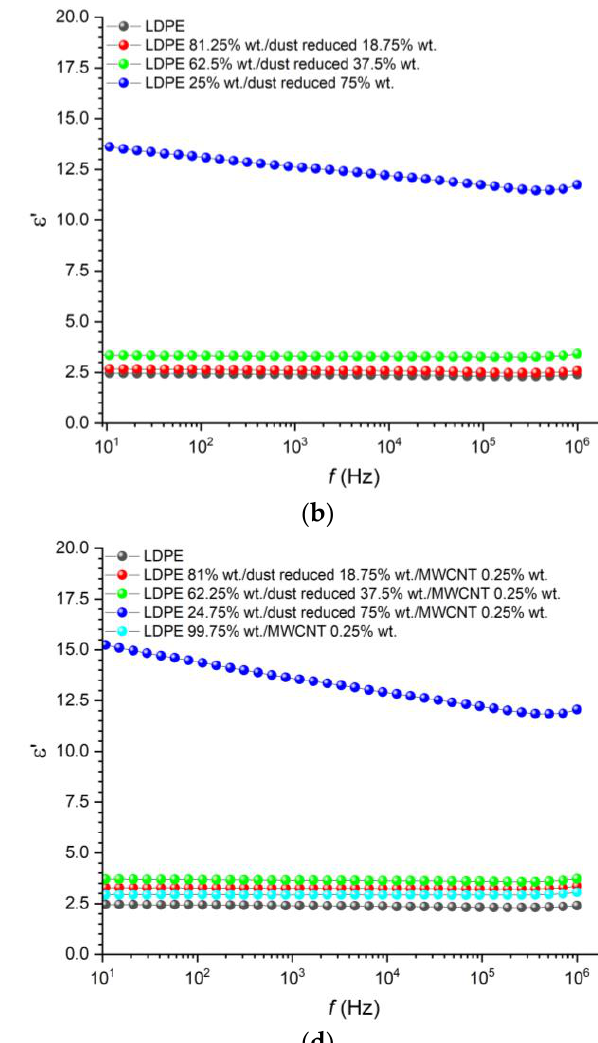
Figure 3. XRD data on reduced dust ( a ) and base dust ( b ) and with phase composition.